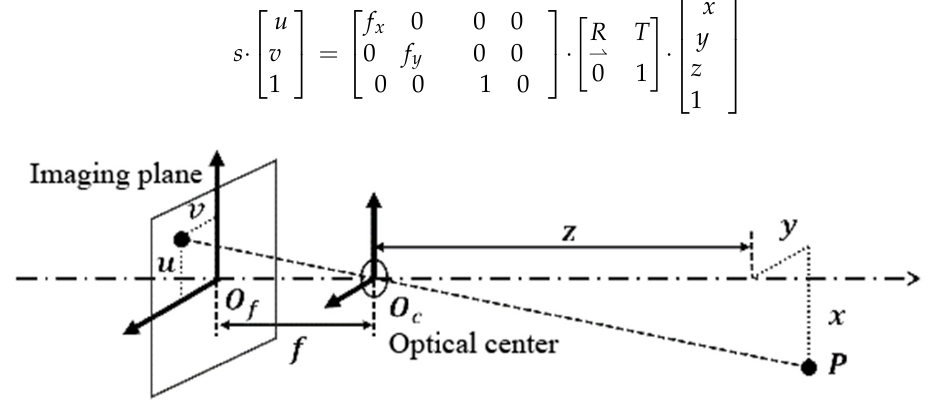
Figure 3. Principle of keyhole imaging.